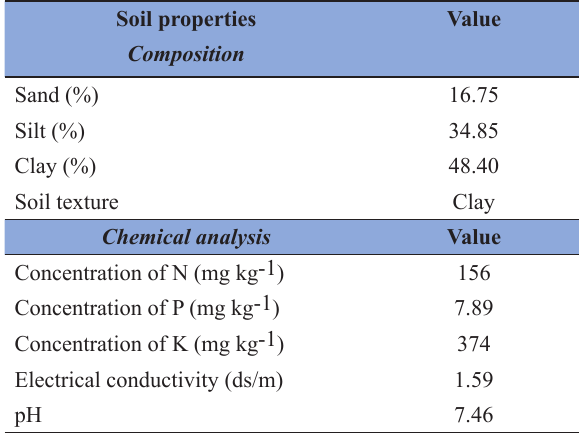
Table 2. Soil composition and chemical properties of the upper 30 cm of the experimental soil for Etay-El-Baroud